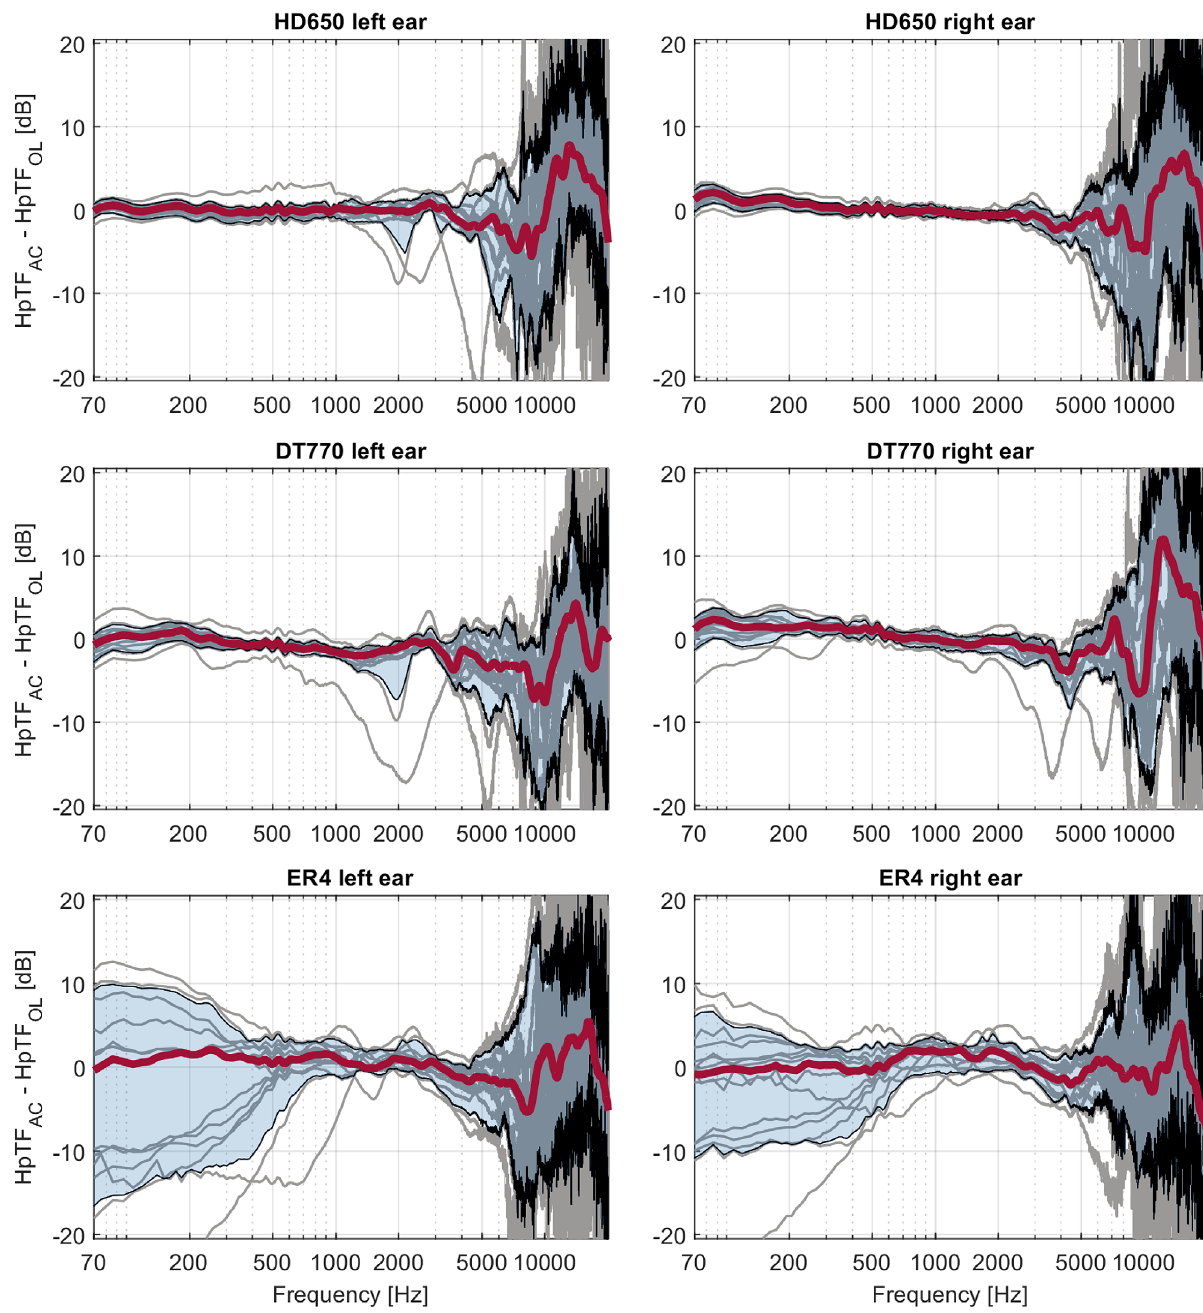
Figure 4. Deviations of the obtained HpTF spectra for each participant across sites for the HpTF magnitude spectra for the different headphones separated by left and right ear. Microphones were positioned close to the eardrum using probe tubes. Left diagram relates to the left and the right diagram to the right ear. Red line shows the median (smoothed by one-twelfth moving average window), in transparent blue the range of 75% of measurement data around the median is plotted. Gray lines indicate an individual